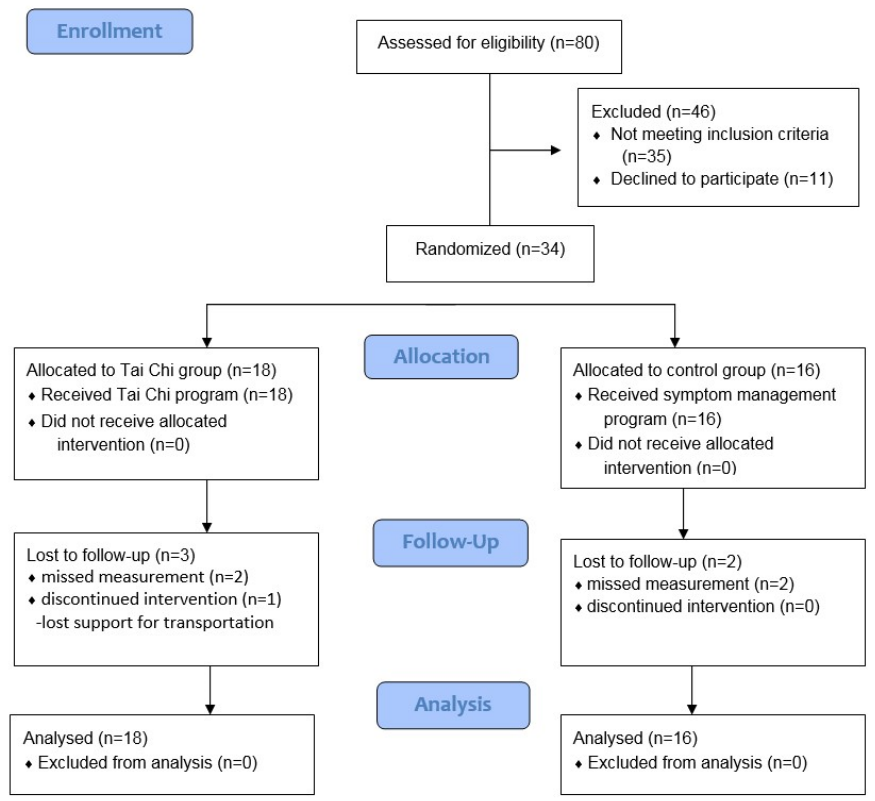
Figure 1. Flow diagram of the study.